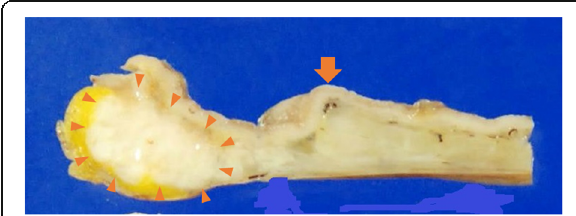
Fig. 4 Resected specimen (gastric antrum and duodenum). Arrow heads: tumor. Arrow: pyloric ring